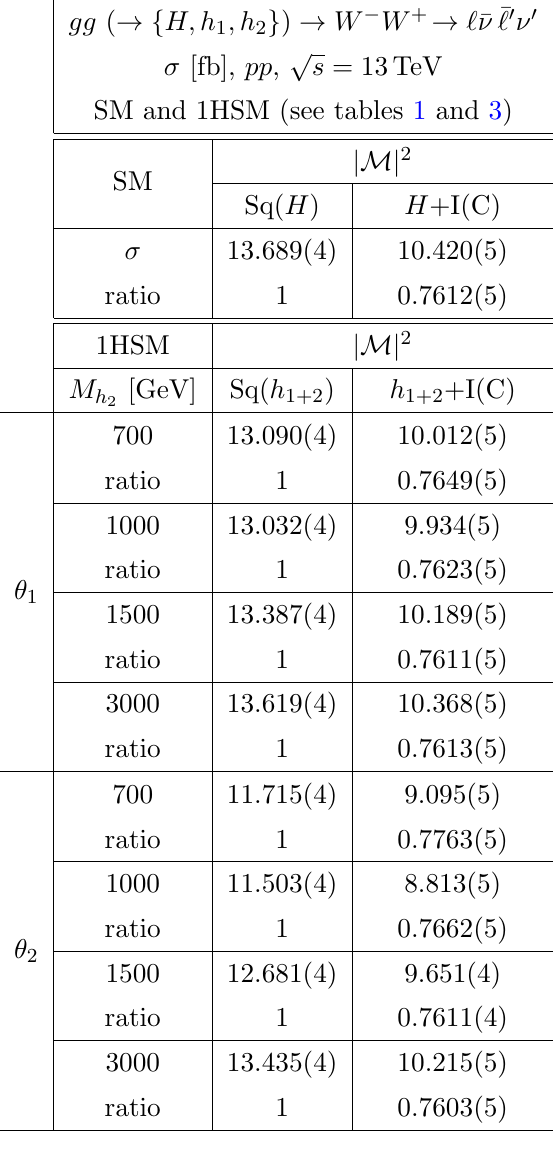
Table 4 . Cross sections for gg ( H; h ; h W (cid:0) W + ‘ (cid:22) (cid:23) (cid:22) ‘ 0 (cid:23) 0 in pp collisions at p s = 13 TeV 1 2 g ) ! ! f ! in the Standard Model with M H = 125 GeV and its 1-Higgs-Singlet Extension with M h = 125 GeV, 1 M h = 700 ; 1000 ; 1500 ; 3000 GeV and mixing angles (cid:18) 1 and (cid:18) 2 (see table 1). Mod-squared amplitude 2 contributions are speci(cid:12)ed using the abbreviations de(cid:12)ned in table 3. The ratio (cid:27)=(cid:27) (Sq( h 1+2 )) is also given. The selection cuts in (4.1) are applied. Cross sections are given for a single